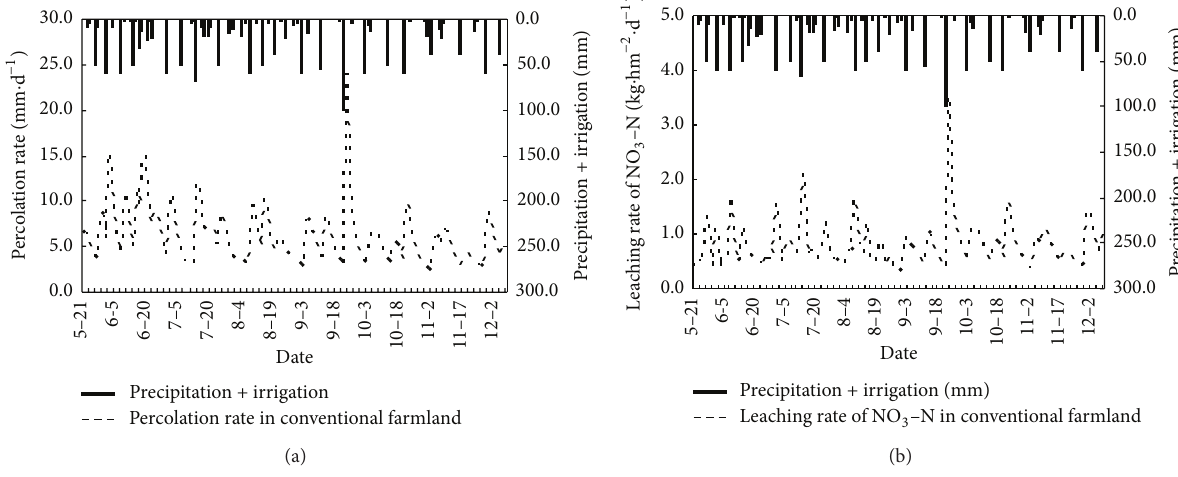
Figure 7: Variation curves of soil water percolation rate and NO 3 -N leaching loss rate with date in intensive vegetable base.